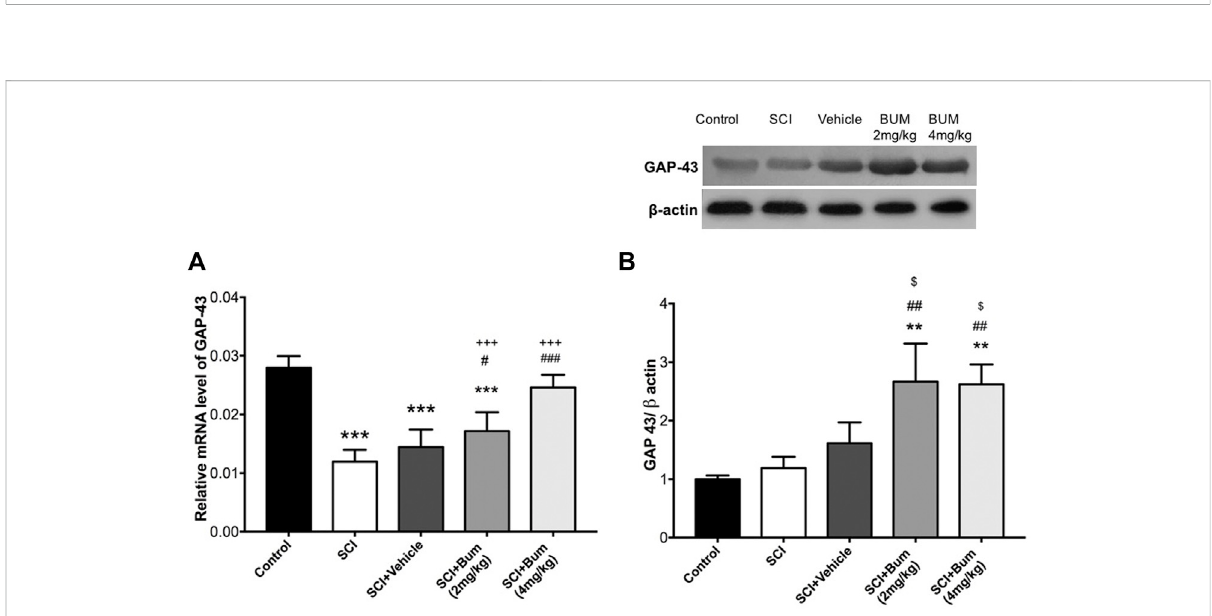
FIGURE 5 (A) GAP-43 gene expression levels of the injured spinal cord at 4 weeks after SCI. Bumetanide enhanced the GAP-43 neurogenesis-related gene expression levels in a dose-dependent manner. (B) Representative Western blots and quantitative data GAP-43 and b-actin expression in the injured segment. Bumetanide increased the GAP-43 marker protein expression levels. *** p ≤ 0.001 vs. the control group; # p ≤ 0.05, ## p ≤ 0.01, ### p ≤ 0.001 vs the SCI group; +++ p ≤ 0.001 vs. Bum 4 mg/kg group; $ p ≤ 0.05 vs. the vehicle group. Data are presented as the mean ± S.D. Loading controls were reused across Figures 4 and 5 of this